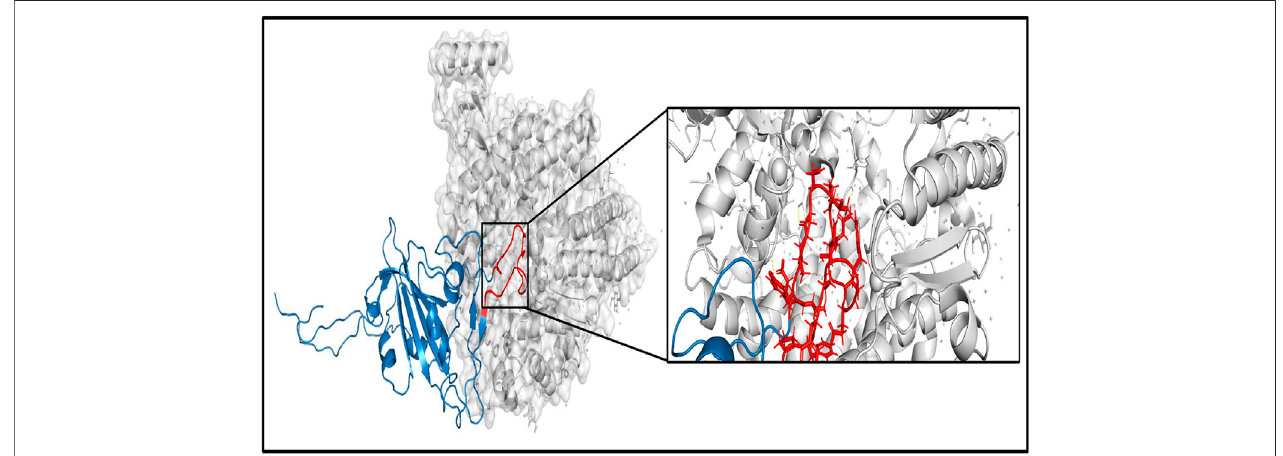
FIGURE 9 | Binding between RBD region of Spike protein (speci fi cally 471 – 492 the region marked in red)) and human ACE2 protein. RBD, receptor-binding domain.